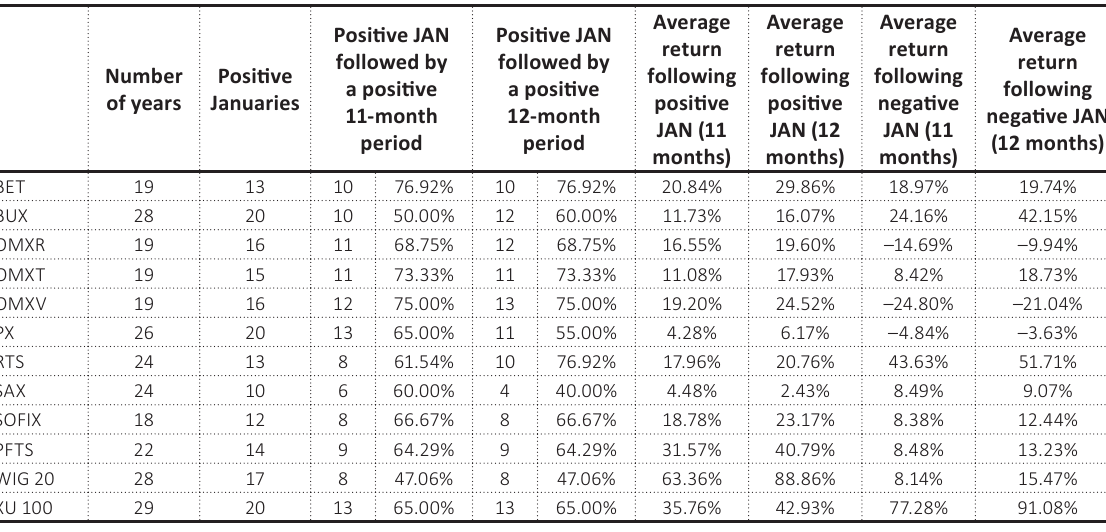
Table 5. January barometer (basic statistics)